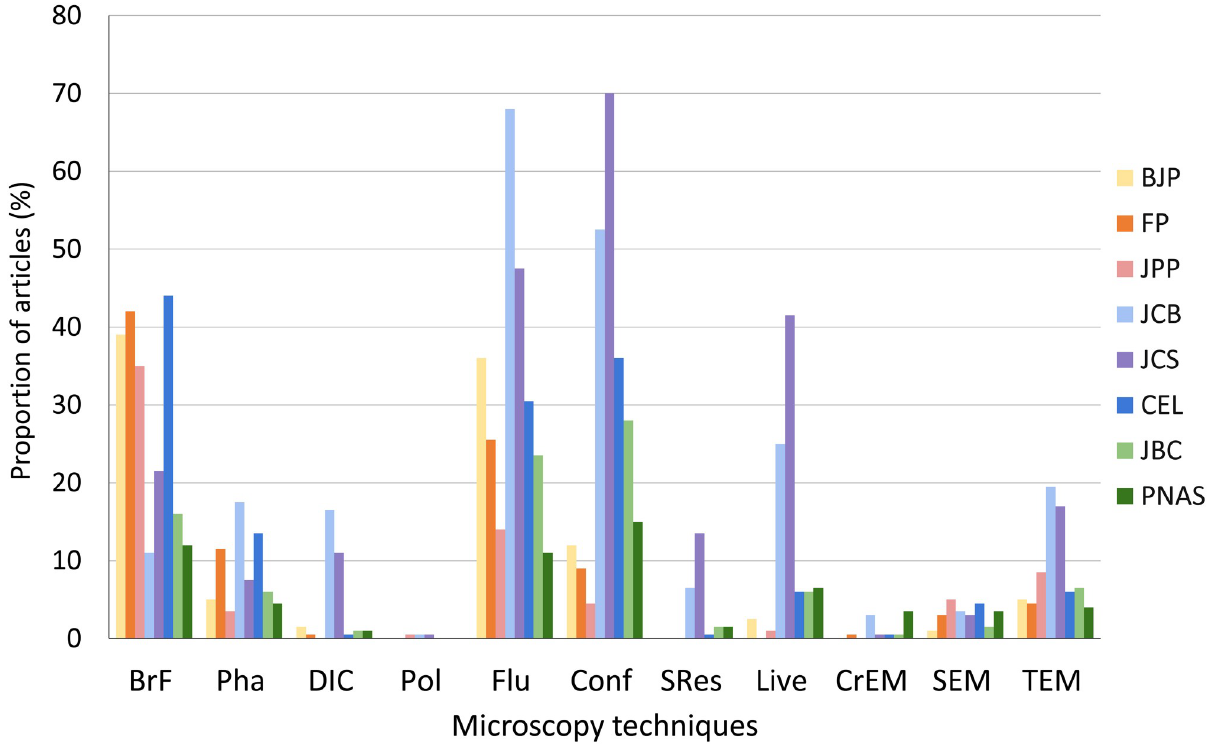
Fig 2. Comparative analysis of the proportion of use of different optical and electron microscopy techniques in biomedical sciences journals. We analyzed in each article the use of 8 types of optical microscopy techniques: bright field (BrF), phase contrast (Pha), differential interference contrast (DIC), polarization (Pol), conventional fluorescence (Flu), confocal fluorescence (Conf), super resolution (SRes), and live cell imaging (Live); and 3 types of electron microscopy techniques: transmission (TEM), scanning (SEM) and cryo-EM (CrEM). Data were collected from articles published in 2019 in the biomedical sciences journals: British Journal of Pharmacology (BJP), Journal of Pharmacy and Pharmacology (JPP), Frontiers in Pharmacology (FP), Journal of Cell Biology (JCB), Journal of Cell Science (JCS), Cells (CEL), Journal of Biological Chemistry (JBC) and Proceedings of the National Academy of Sciences (PNAS). N = 200 articles analyzed in each scientific